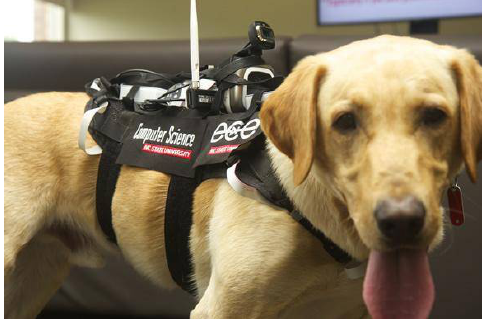
Figure 5. Posture system used by Majikes et al. [36].